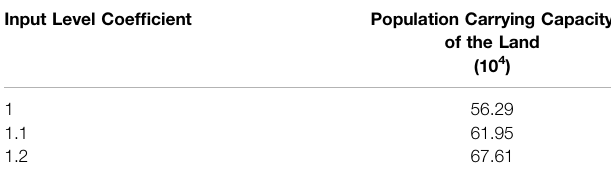
TABLE 5 | Land population carrying capacity under different input level coef fi